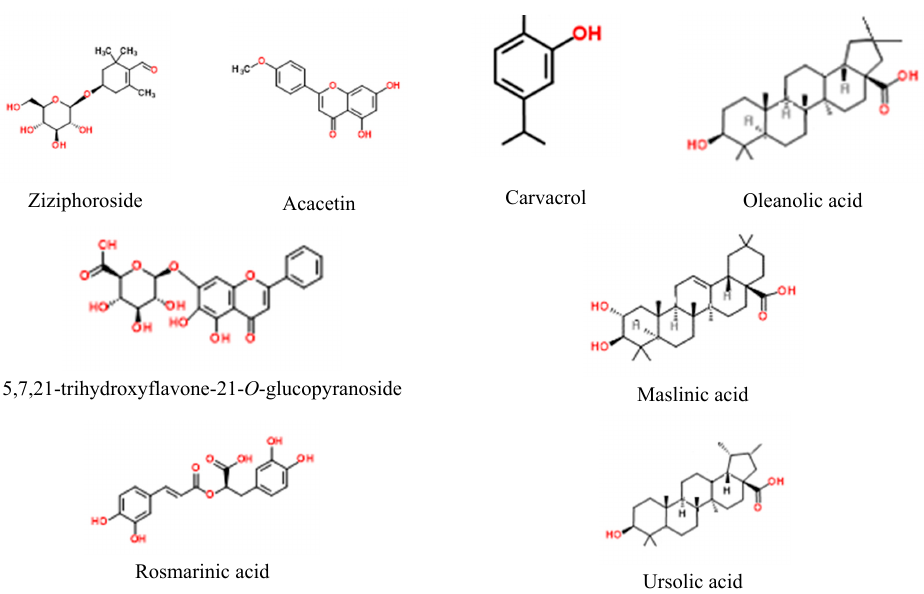
Figure 1. Structure of the components identified in Ziziphora bungeana extracts . The applied LC-MS technology enabled the identification of components, e.g., thy- mol, carvacrol, or ziziphorosides, that were previously determined in Ziziphora spp. by GC-MS technique. Milder fragmentation conditions (fragmentation voltage of 110 V, ca- pillary voltage of 3000 V, gas temperature of 275 °C and collision energy of 10 V) increased the chance to observe terpene compounds in the chromatogram in the liquid chromatog- raphy-based system. Ziziphoroside isomers, possibly ziziphoroside A, B, and C, were pre- sent in the mass spectra in the form of adducts with sodium ions. The remaining com- pounds were traced in the form of molecular ions with or without a proton.